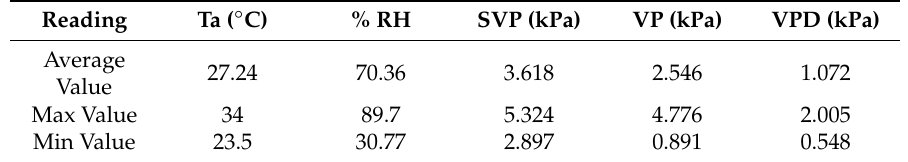
Table 2. Vapor pressure density (VPD) calculations based on 1 foot height under agrivoltaic conditions. Reading